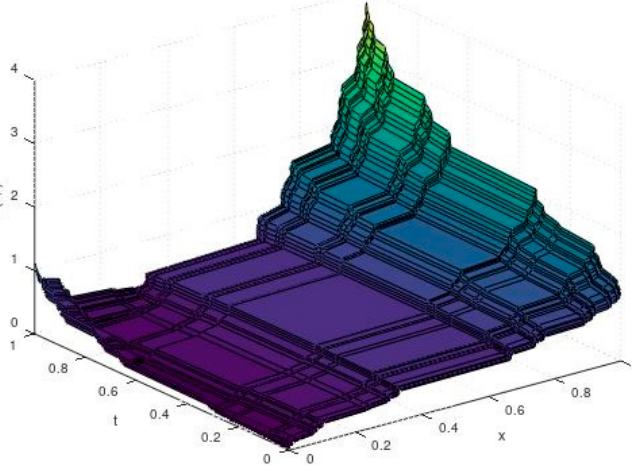
Figure 3. Outcome of Example 2 for α = 0.932 at n = 2.